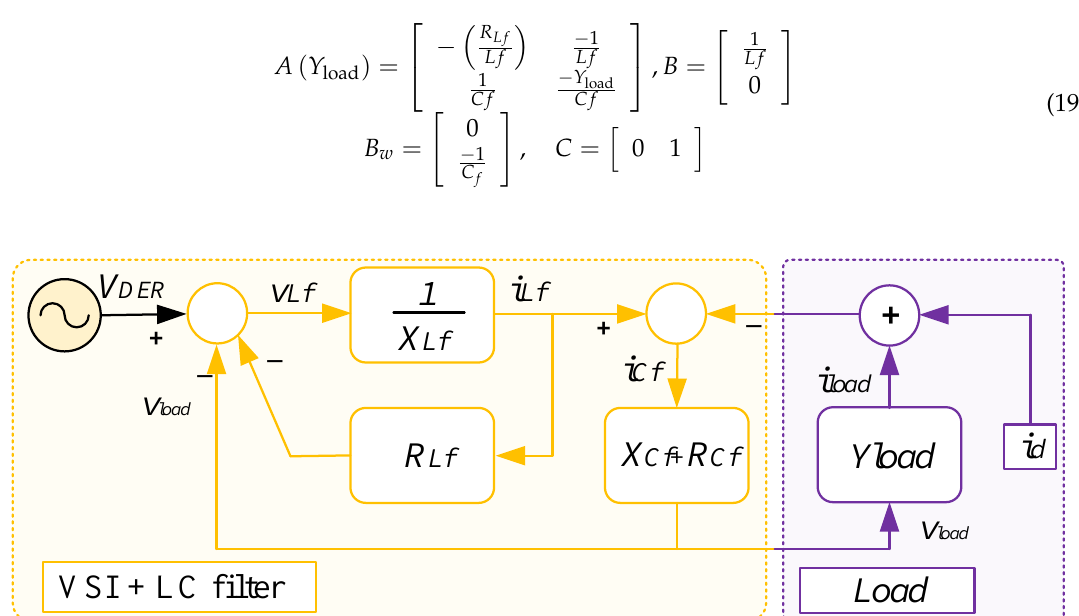
Figure 2. Inverter block diagram with filter and